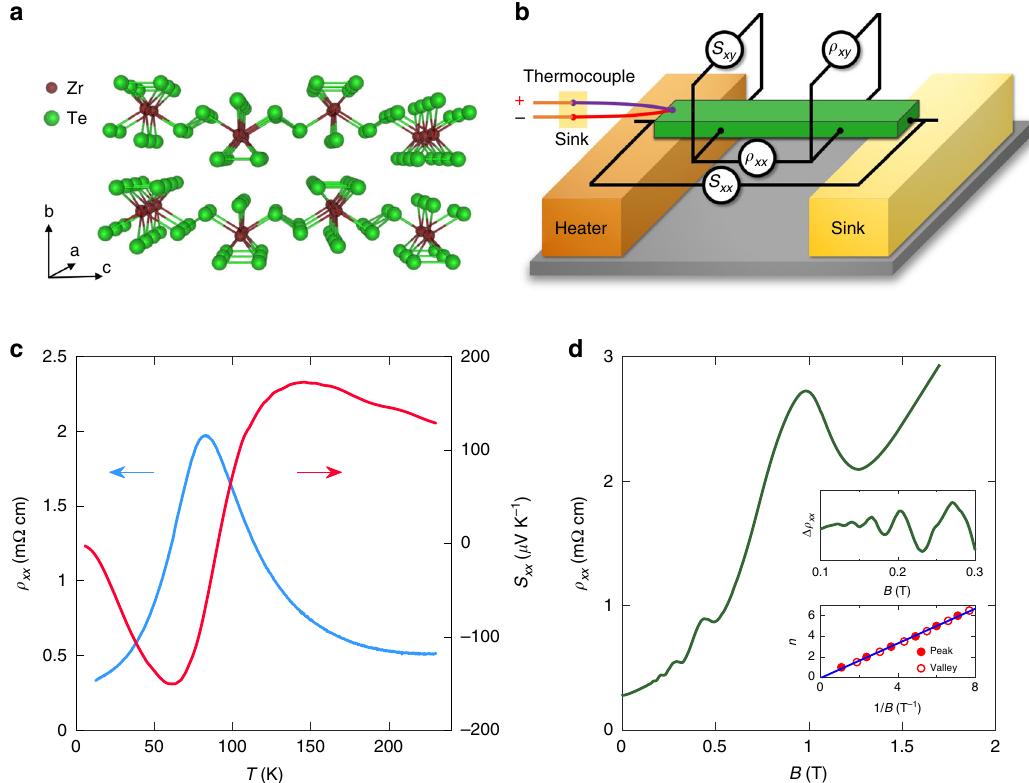
Fig. 1 Measurement setup and resistivity. a The crystal structure of ZrTe 5 . b The measurement setup for resistivity and thermoelectric measurements. c Temperature dependence of the electrical resistivity (blue curve, left vertical axis) and the thermopower (red curve, right vertical axis). d Magnetoresistance at 1.5 K. On top of a strong positive magnetoresistance, SdH oscillations are evident (upper inset). The onset fi eld of the oscillations is 0.13 T, indicating a high mobility. The system enters the EQL at ≈ 2 T. The lower inset shows the index n of the minima and maxima of each oscillation as a function of 1 ∕ B